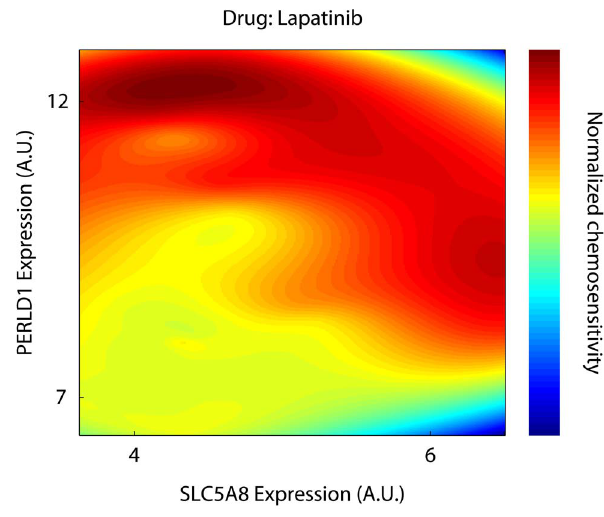
Figure 6. Drug sensitivity heatmap as a function of the two most important genes. Drug activity is to some extent predictable using molecular markers.